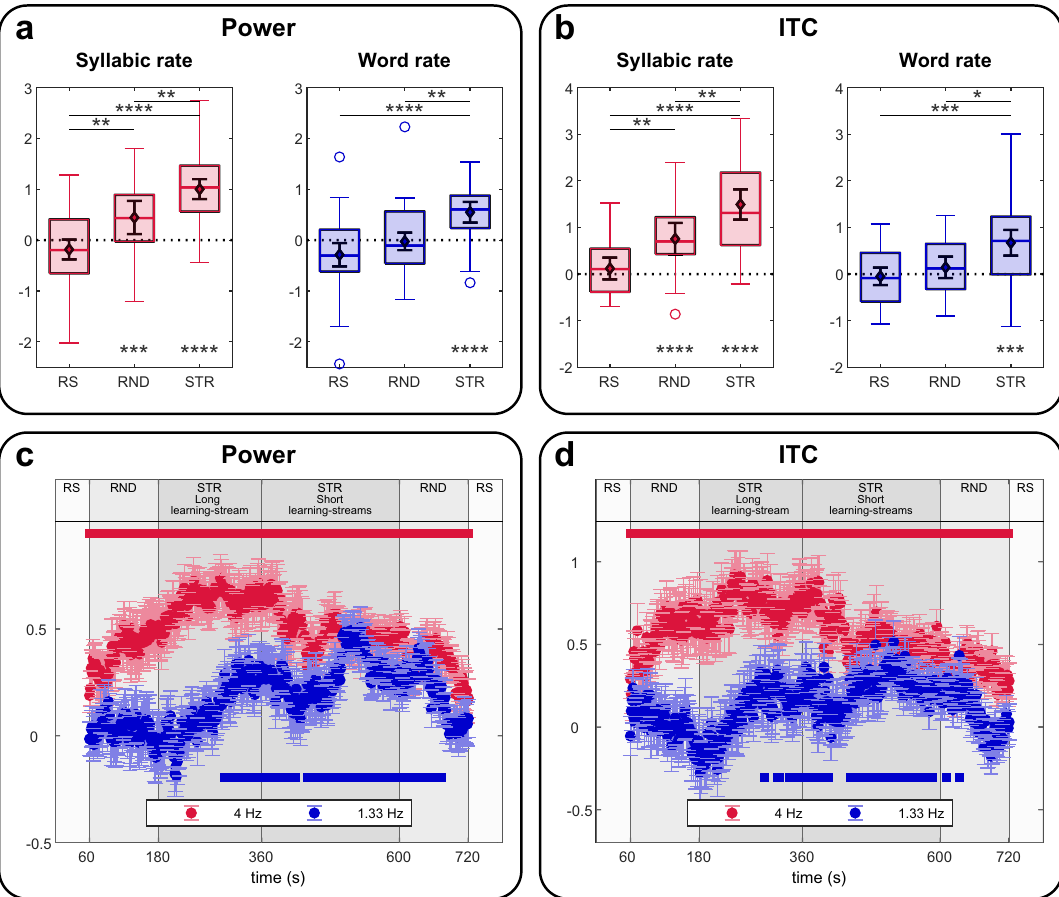
Figure 3. Neural entrainment. ( a ), SNR for the power at the Syllable and Word rate during the three conditions (RS = resting state, RND = random stream, STR = structured stream). Asterisks represent Bonferroni corrected p-values *** < 0.001, ** < 0.01 * < 0.05. ( b ), Same as ( a ) for ITC. ( c ) Time course of entertainment based on power computed on 120 s time windows. The times on the x-axis correspond to the center of the time windows. Error bars represent standard errors. The red line on the top indicates when the power at the Syllabic rate (4 Hz) was larger than the null hypothesis 0 (p < 0.05, one-sided t-test, corrected by FDR). The blue line on the bottom indicates when the power at the Word rate (1.33 Hz) was larger than the null hypothesis 0 (p < 0.05, one-sided t-test, corrected by FDR). ( d ), Same as ( c ) for